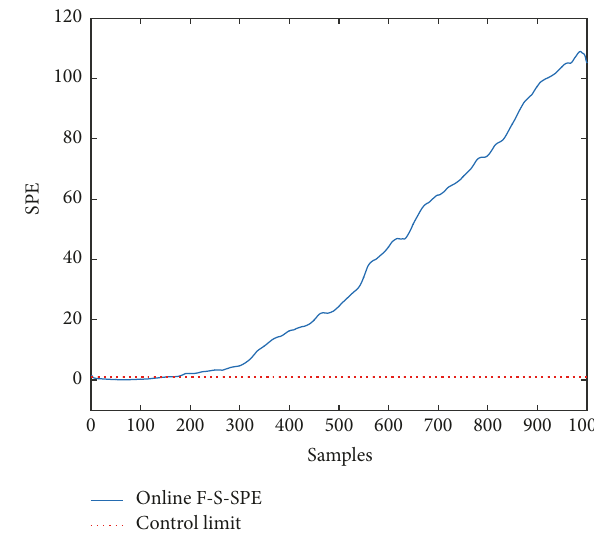
Figure 5: The fitted RUL prediction model based on PCA.